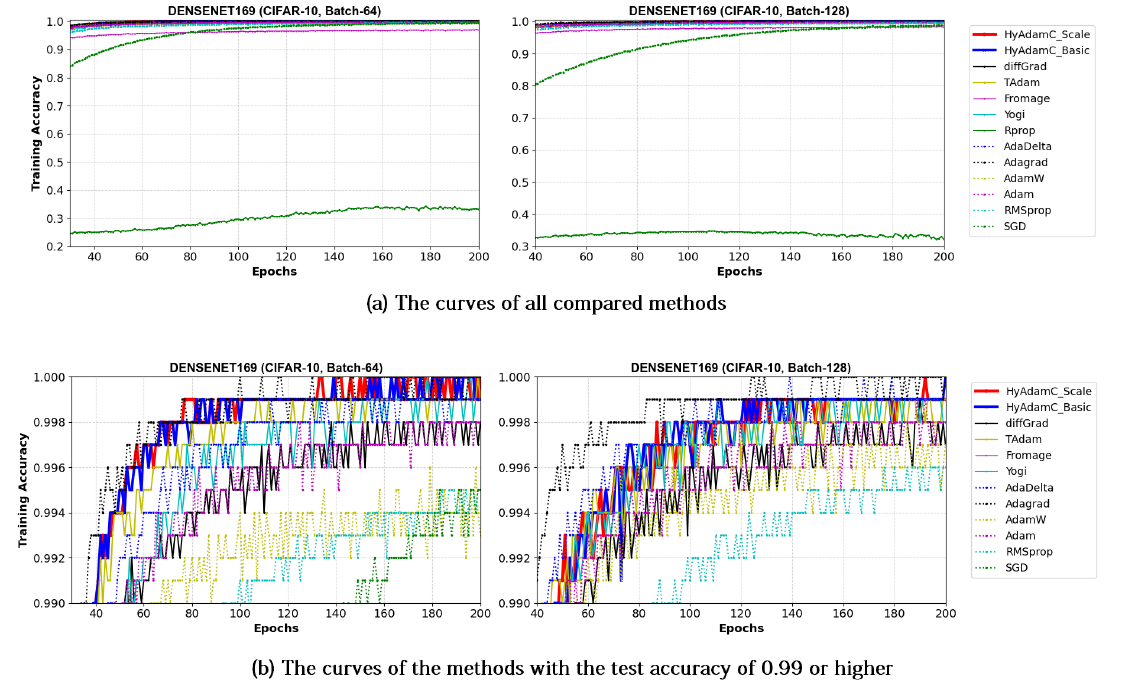
Figure 22. The training accuracy curves of the DenseNet-169 trained by HyAdamC and other optimization methods in the CIFAR-10 image classification tasks. In this figure, ( a ) shows the training accuracy curves of all compared methods. On the other hand, ( b ) illustrates the plots in which a range of the y-axis of the plots described in ( a ) is zoomed into between 0.99 and